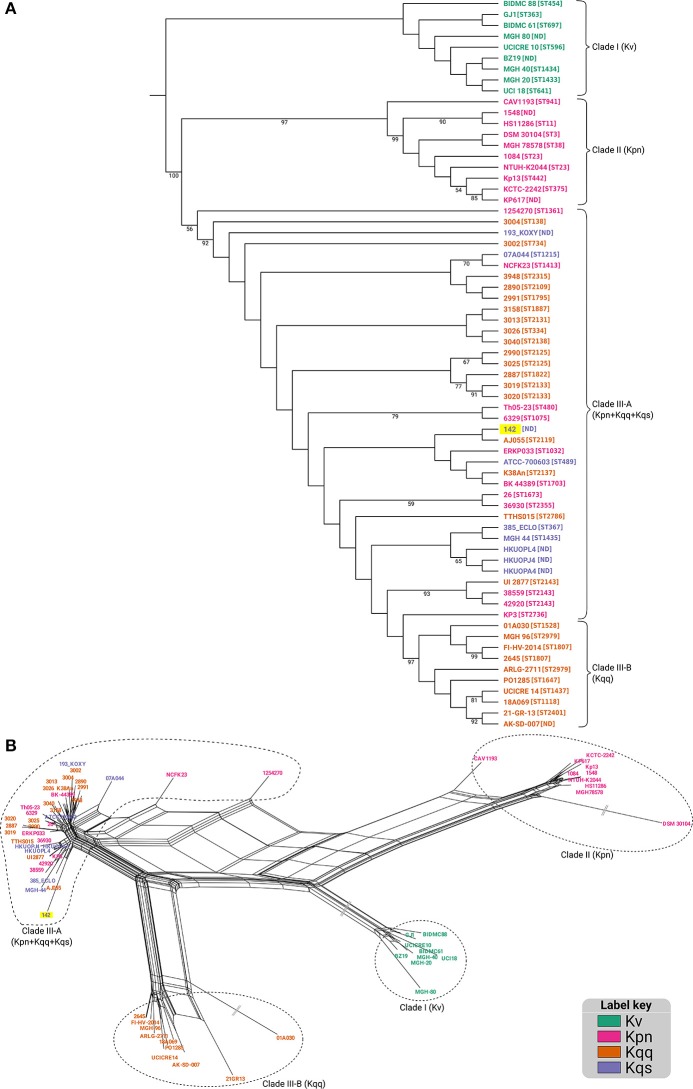
(A) Maximum likelihood tree for the matrix consisting of the concatenated allele sequences for seven housekeeping genes (gapA, infB, mdh, pgi, phoE, rpoB, and tonB) loci, constructed with PhyML, using the GTR+I+G model of nucleotide substitution. 1,000 bootstrap replicates were calculated to assess robustness. 1,000 bootstrap replicates were calculated to assess robustness, and support values >50% are shown. (B) Split decomposition analysis using the seven MLST alleles reveals a network-like structure, suggestive of recombination events. “||” represent long branches that were truncated to fit (see Figure S3 for the complete network). In both panels, KPC-142 is labeled on a yellow background and in the (panel A) the ST number of each isolate/strain is in brackets.